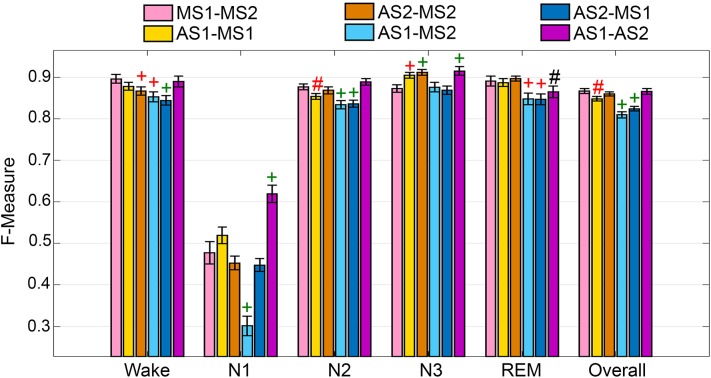
Manual versus automated scoring inter-scorer agreement for UMH cohort. Generalization of all UMH recordings (n = 24) between different combinations of manual (MS1, MS2) and automated scoring (AS1, AS2) inter-scorer agreements. Data analyzed by paired t-test, represented as mean ± SEM. #p < 0.01; +p < 0.001. Symbol color represents effect size (g): black, small; red, medium; green, large.